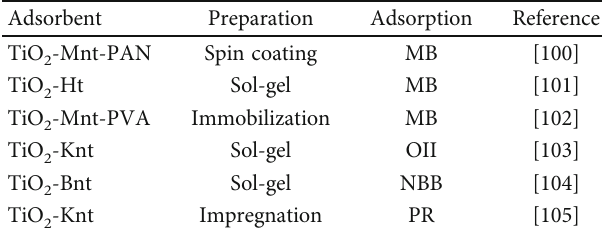
Table 4: Summary of TiO methodologies and their consumption for adsorption of dyes in the last